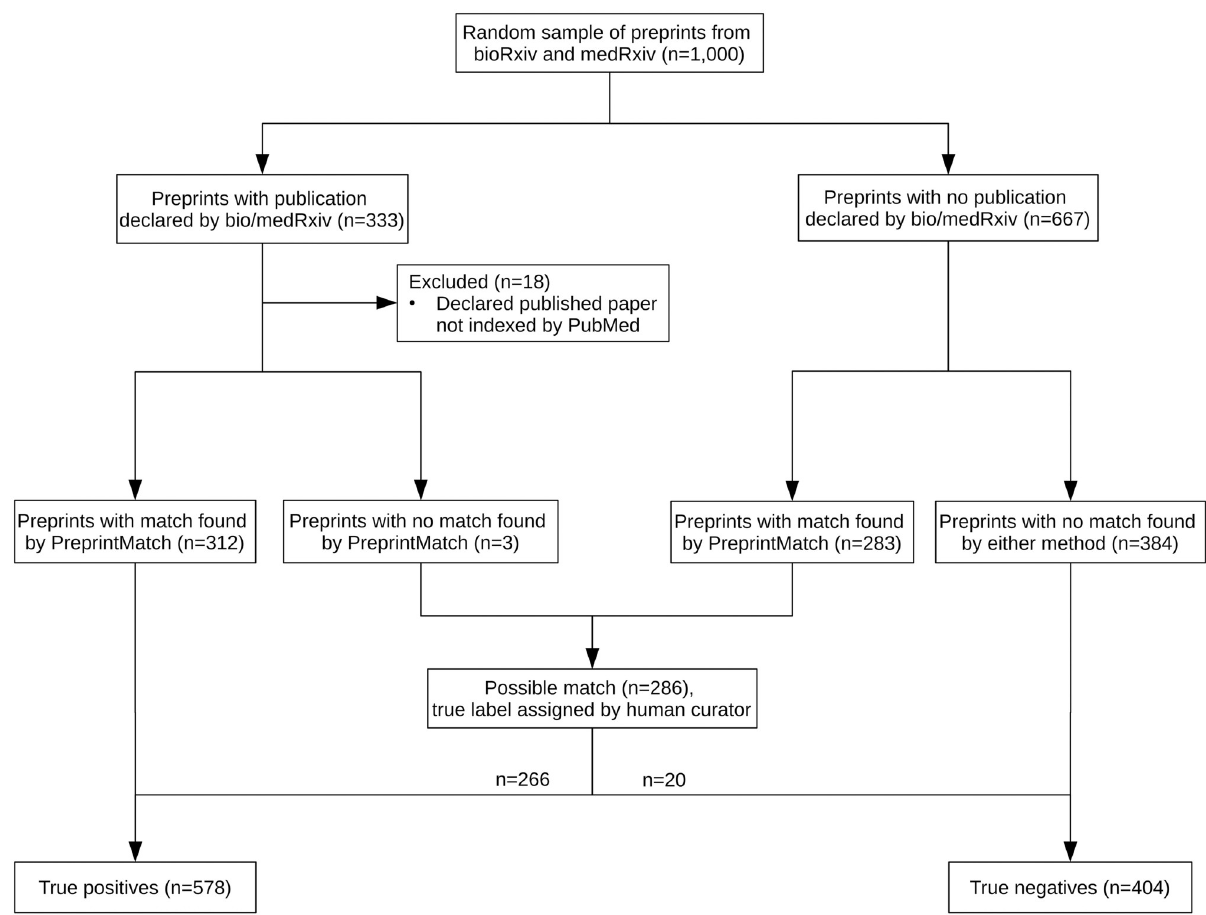
Fig 2. Construction of test set. CONSORT-style flow diagram showing the process of test set construction. Starting with a simple random sample of 1,000 preprints from the set of all bioRxiv and medRxiv preprints, 578 were considered true positives and 404 true negatives. Preprints were classified as true negatives when both bio/medRxiv and PreprintMatch did not report a match, and true positives when they both reported the same matched paper. In all other cases, manual curation was used to assign the true